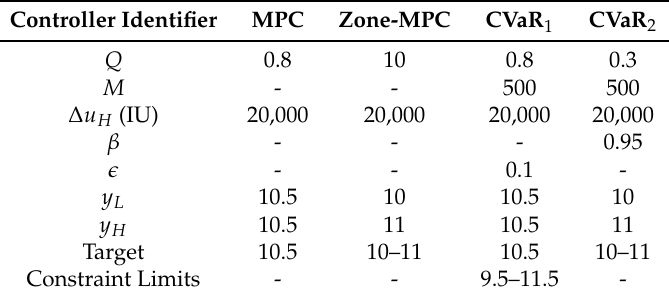
Table 1. Controller settings.